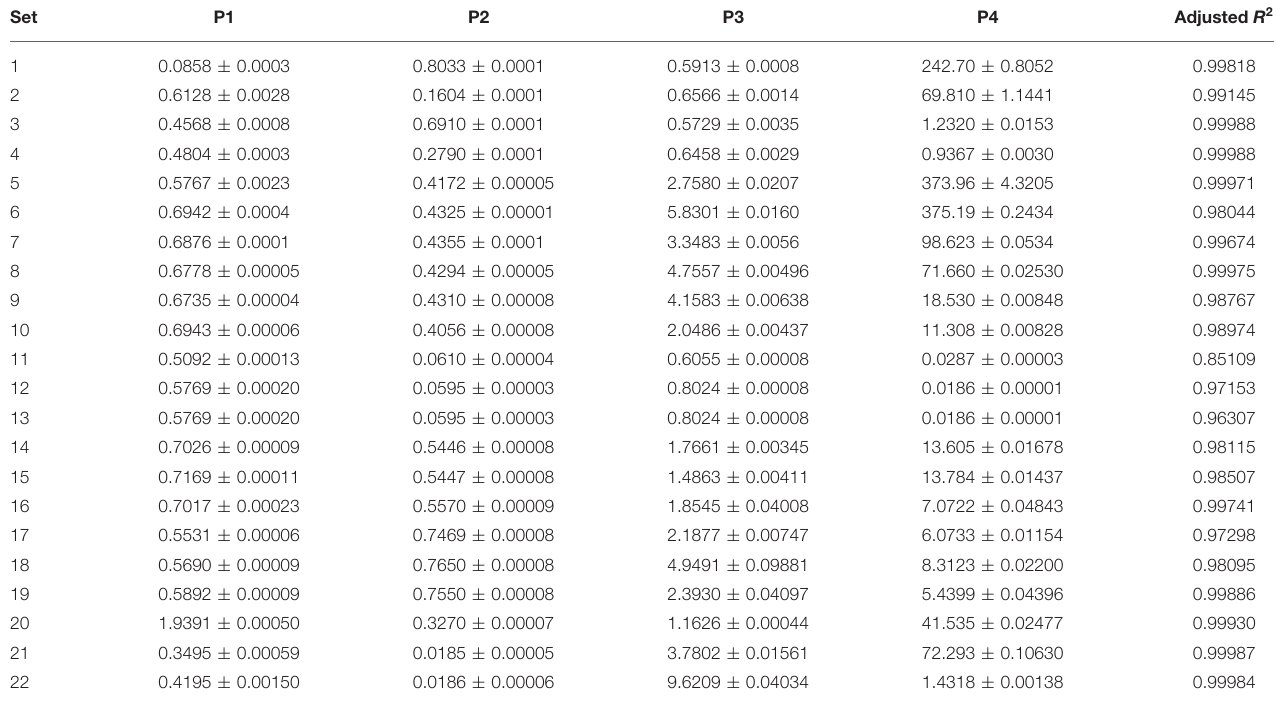
TABLE 3 | Statistical properties of the algorithm (A) outputs.